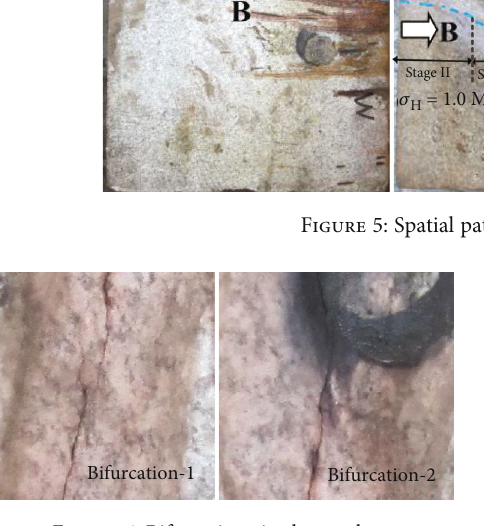
Figure 6: Bifurcations in the cracks.